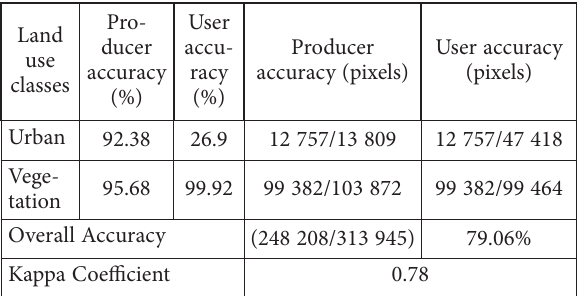
Table 5. Object based accuracy assessment using